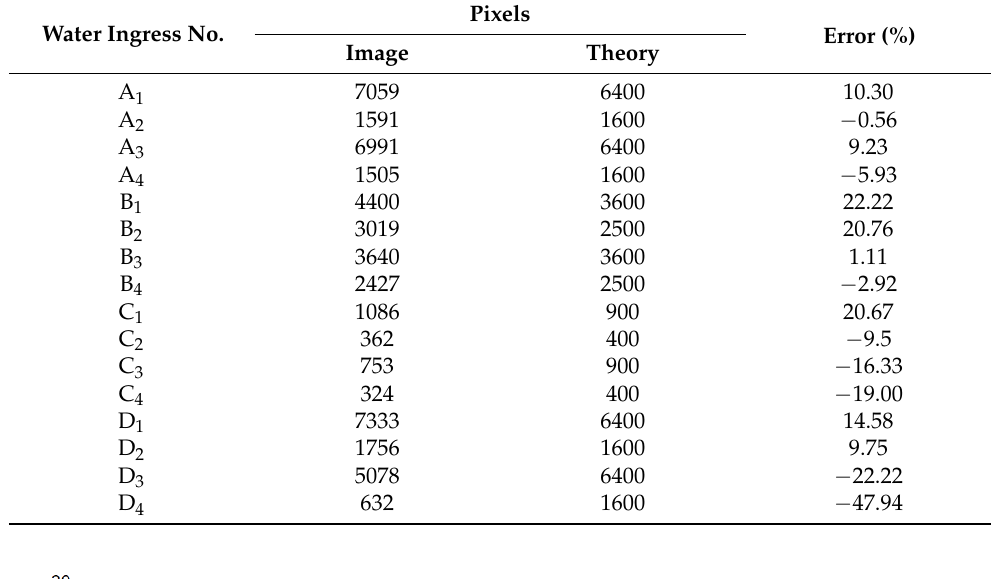
Water Ingress No.